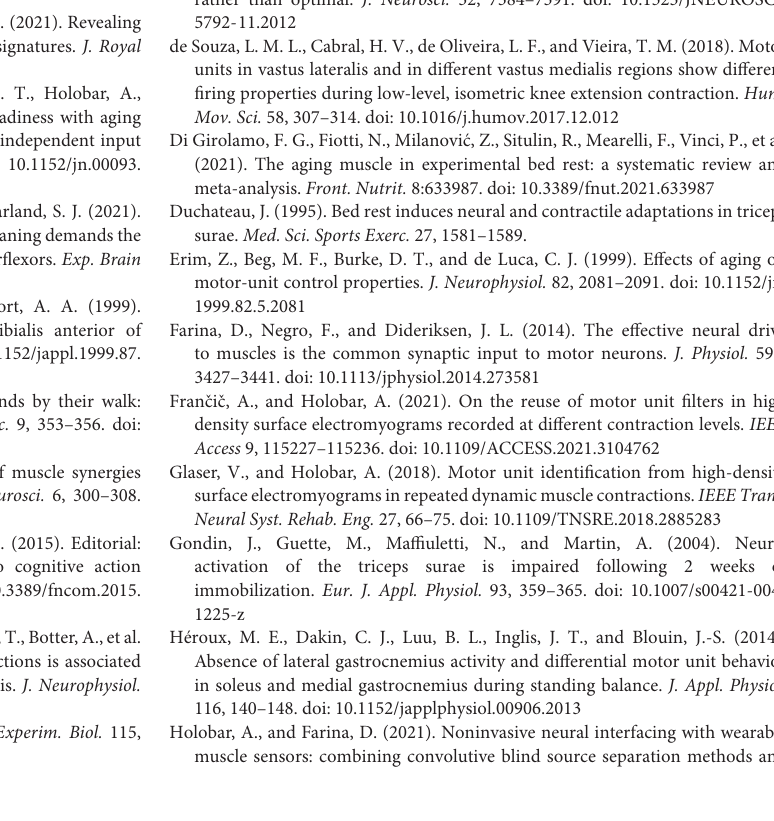
Frontiers in Physiology |